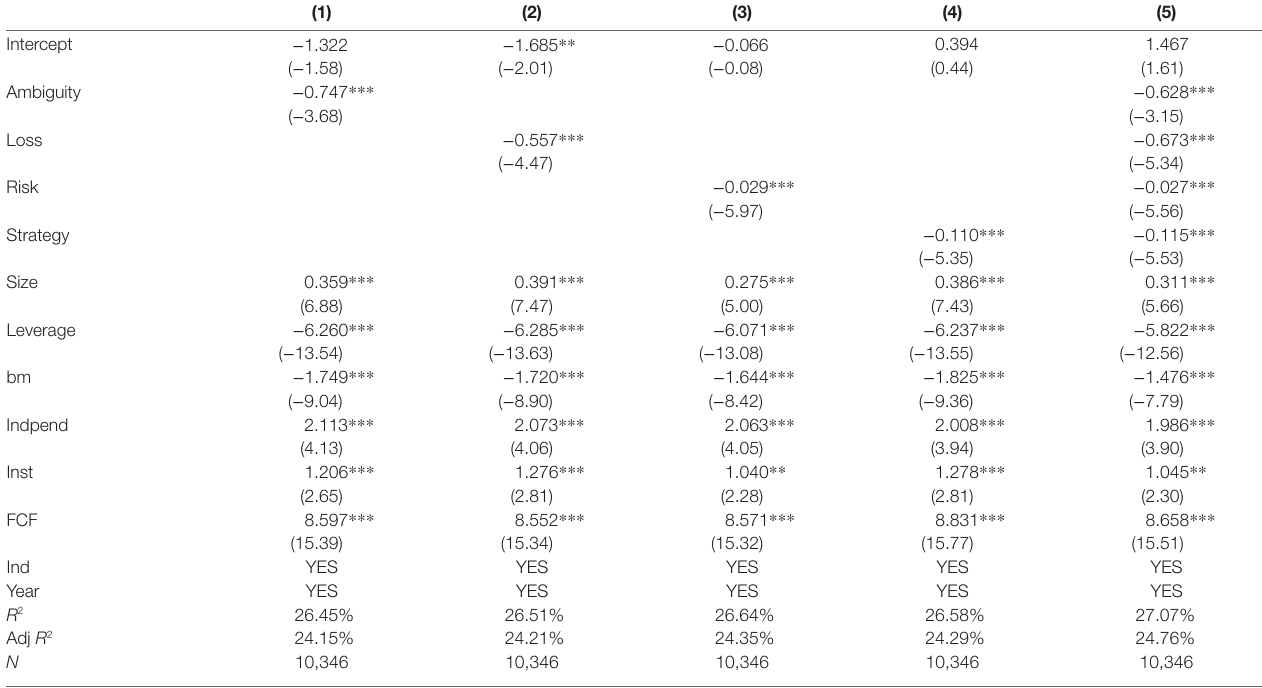
TABLE 6 | The effect of behavior foundations and business strategy on share